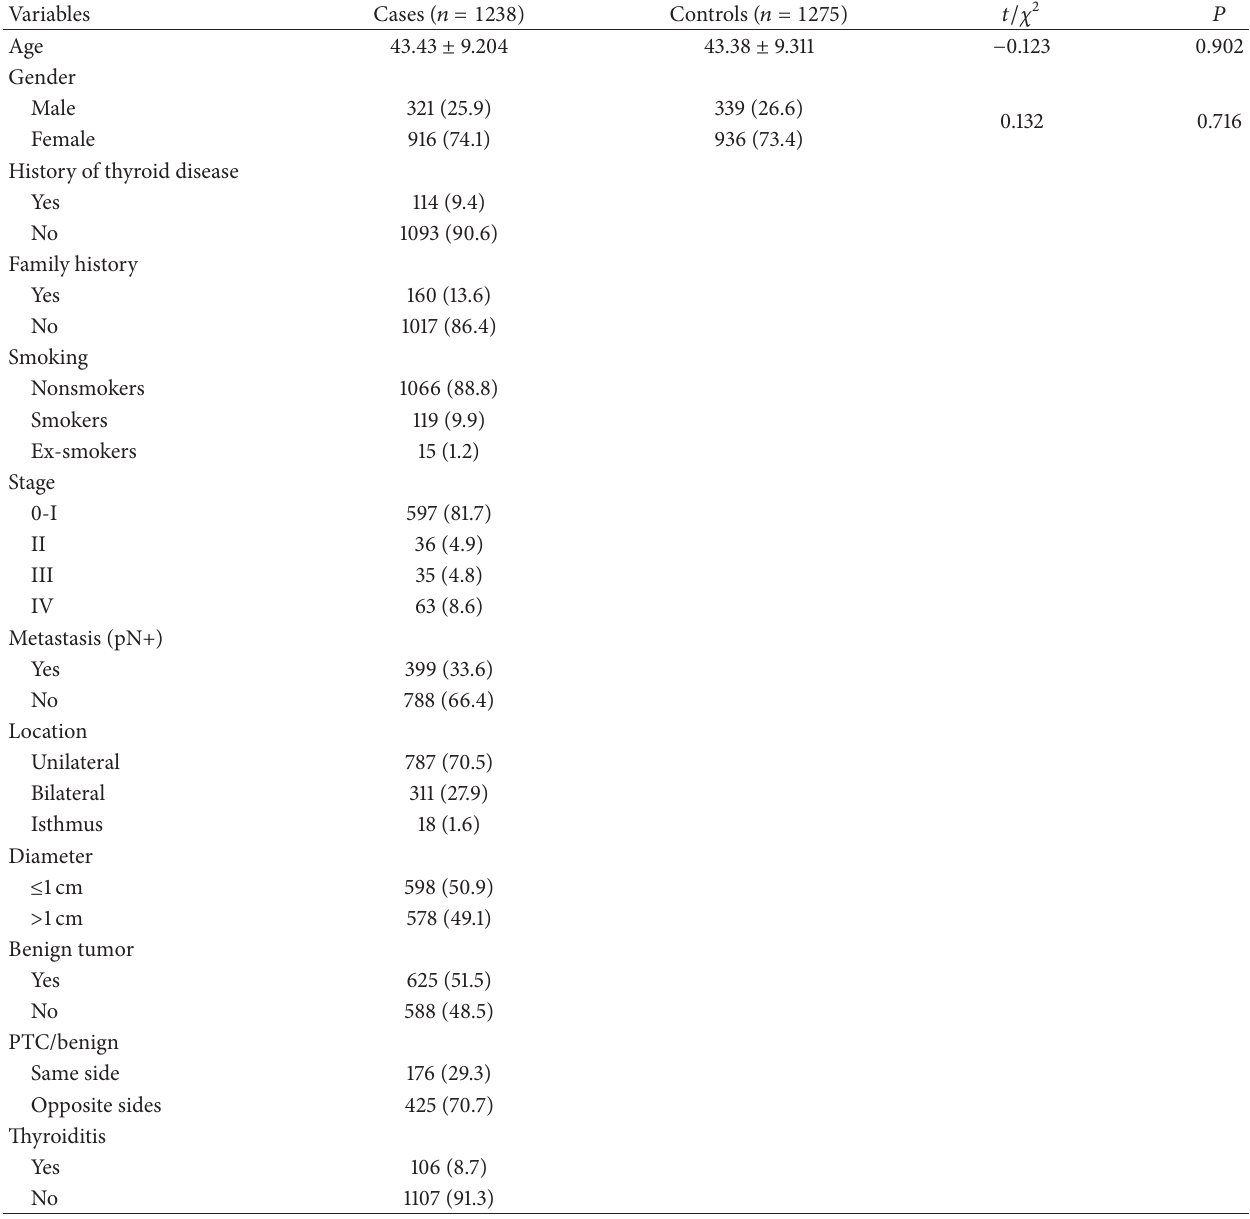
Table 1: Characteristics of the study